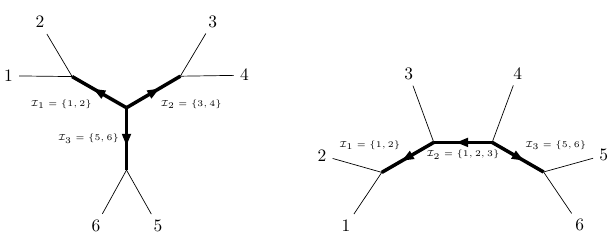
Figure 7 . Two distinct 3-partitions of 6-point amplitudes specified by three subsets {I 1 , I 2 , I 3 } . The arrows suggest a clarifying way to associate each subset with an internal line that potentially represents a